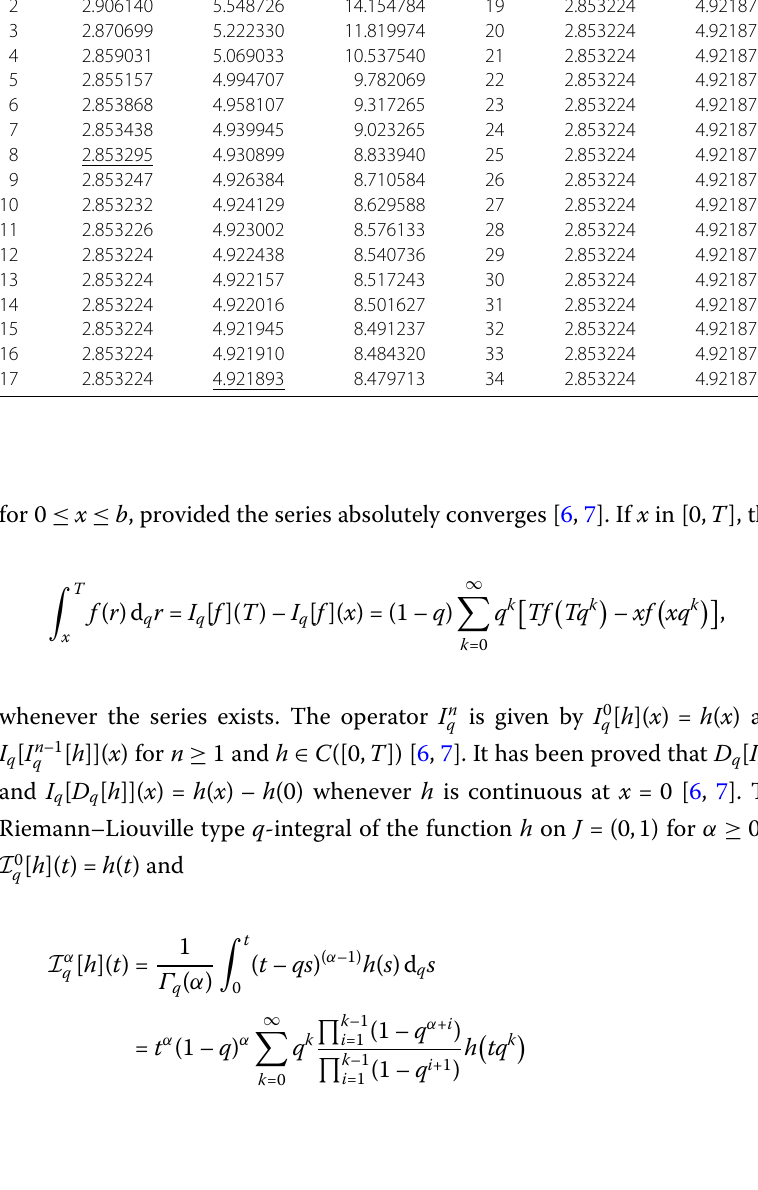
that is constant, x = 4.5,8.4,12.7, 3